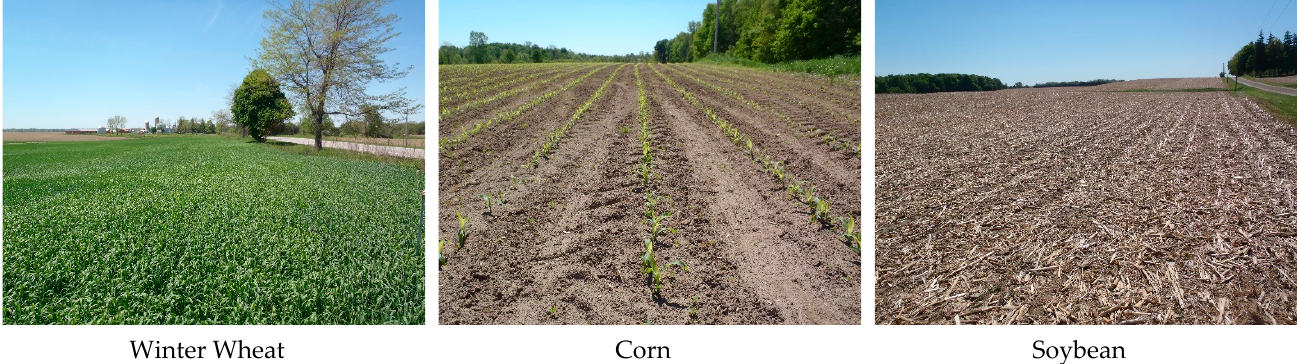
Figure 3. Field photos of three main crop types over the study site on 23 May when the field survey for corn and soybean fields started.